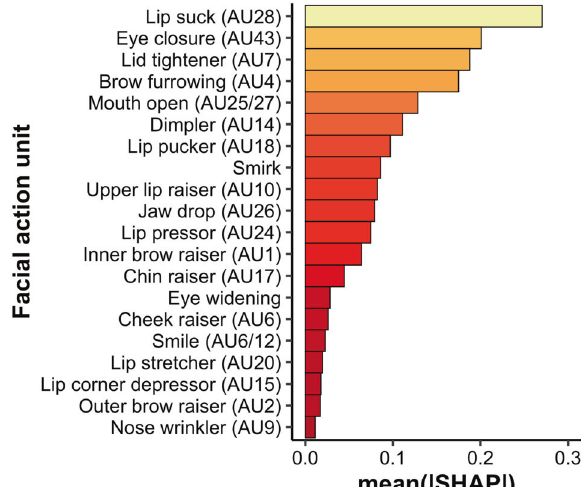
Fig. 2 Unique importance of individual facial action units (AU) in classifying painful and nonpainful states. Following machine- learning classi fi cation, we calculated Shapley Additive explanations (SHAP) values, which indicate the relative contribution of each individual AU in distinguishing periods of painful leg pressure from periods of innocuous, nonpainful, leg pressure. AUs are numbered according to their corresponding Facial Action Coding System (FACS) code. The AUs “ Smirk ” and “ Eye widening ” , as estimated by the AFFDEX algorithm, do not correspond to speci fi c AUs in the FACS